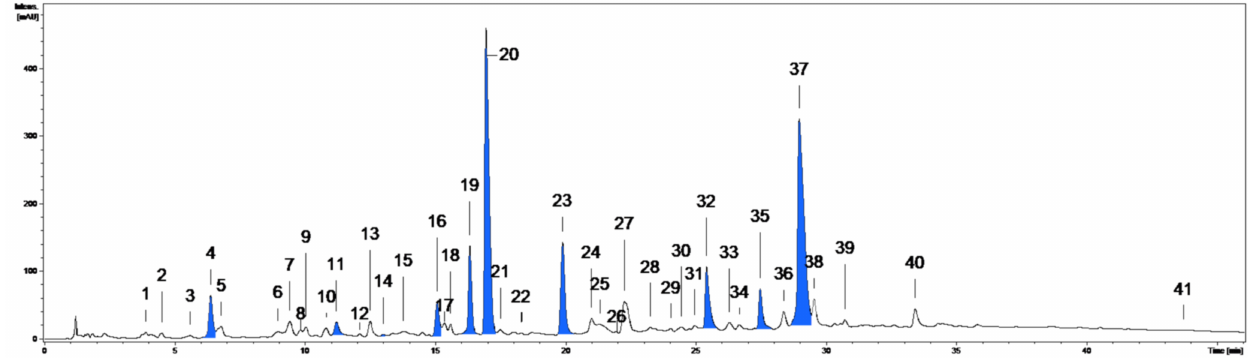
Figure 1. Representative UHPLC-PDA chromatogram of the aerial parts extract ME-AP at 280 nm. The peak numbers refer to those implemented in Table S1. The model compounds (coloured peaks): 4 , NCHA (neochlorogenic acid); 11 , CHA (chlorogenic acid); 14 , CCHA (cryptochlorogenic acid); 16 , PB2 (procyanidin B2); 19 , ECA (( − )-epicatechin); 20 , GT (gaultherin); 23 , CB1 (cinnamtannin B-1); 32 , DGQ (wintergreenoside A); 35 , HY (hyperoside); 37 , MQ (miquelianin); 41 , QU